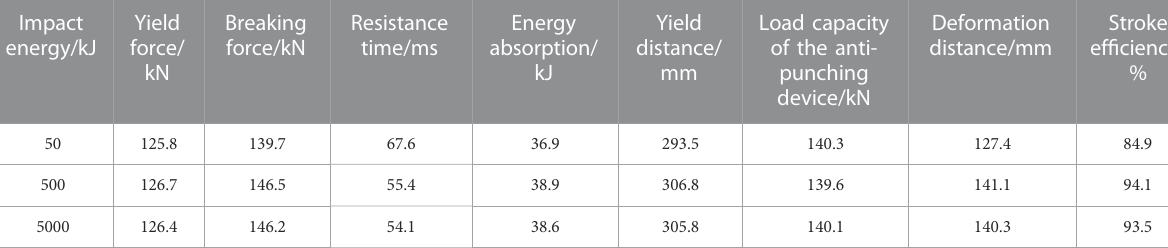
TABLE 3 Mechanical properties of anchor bolts at different impact energies. Impact energy/kJ